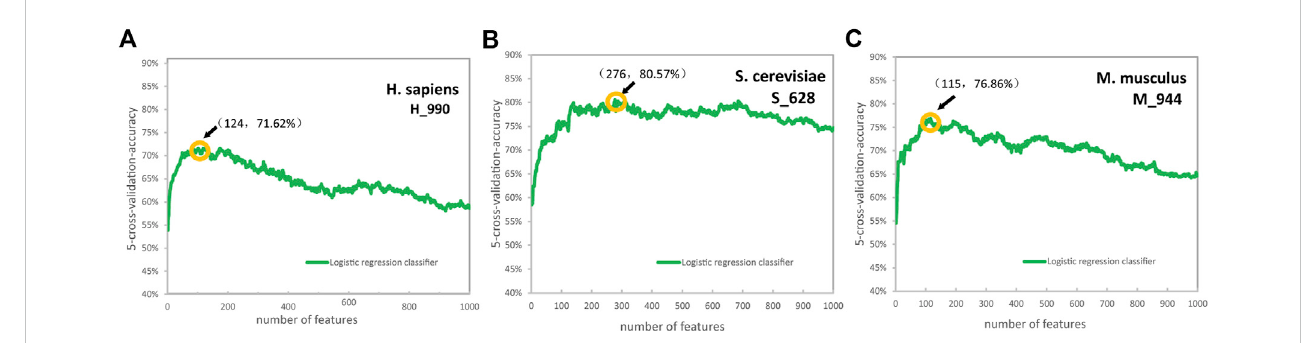
FIGURE 3 Theaccuracycurvesfor H.sapiens (A) , S.cerevisiae (B) ,and M.musculus (C) oftheposition-speci fi cofthreenucleotidesencodingschemes. (Duetothe excessive dimensions of position-speci fi c of three nucleotides features, 1000 features were selected for drawing for convenience).